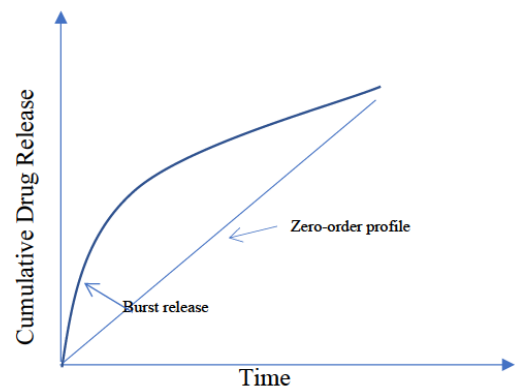
Figure 5: Schematic representation of the cumulative drug release vs